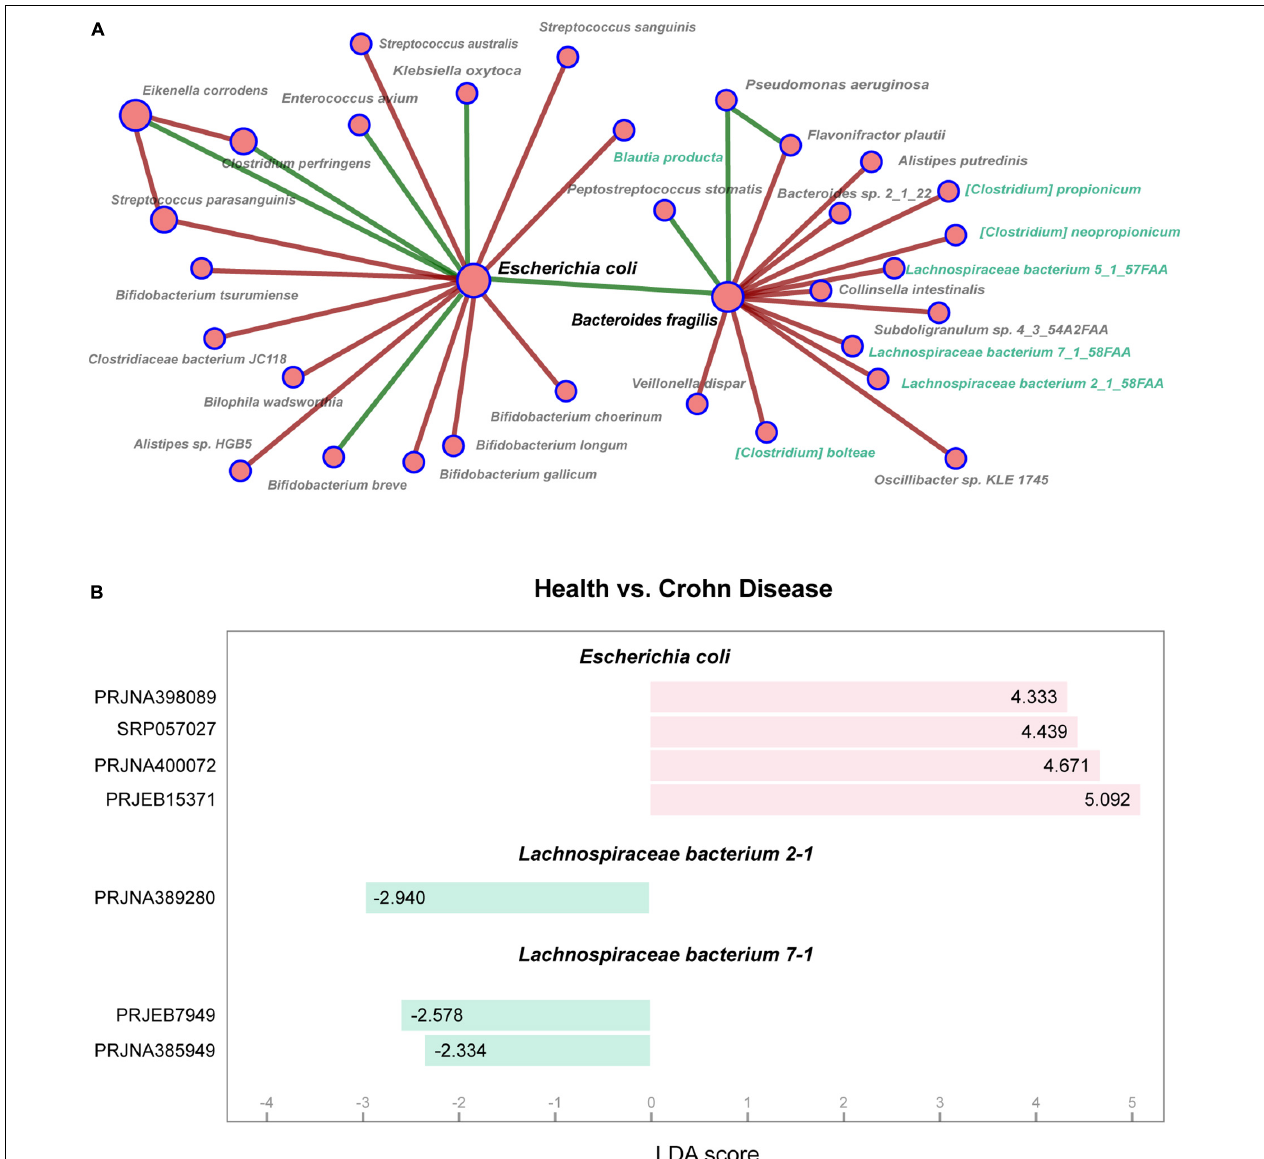
FIGURE 1 | Analysis of gut microbiota in patients with Crohn’s disease. (A) Partial of co-occurrence microbial network in patients with Crohn’s disease shows relationships among gut microbes. The node sizes are proportional to the number of connected nodes in the network, and the colors indicate positive (green) or negative (red) correlations. The nodes marked with green belong to Lachnospiraceae family. (B) Marker taxa are shown between health and Crohn’s disease using LEfSe analysis. Y-axis represents BioProject ID in NCBI, and X-axis represents LDA scores calculated by